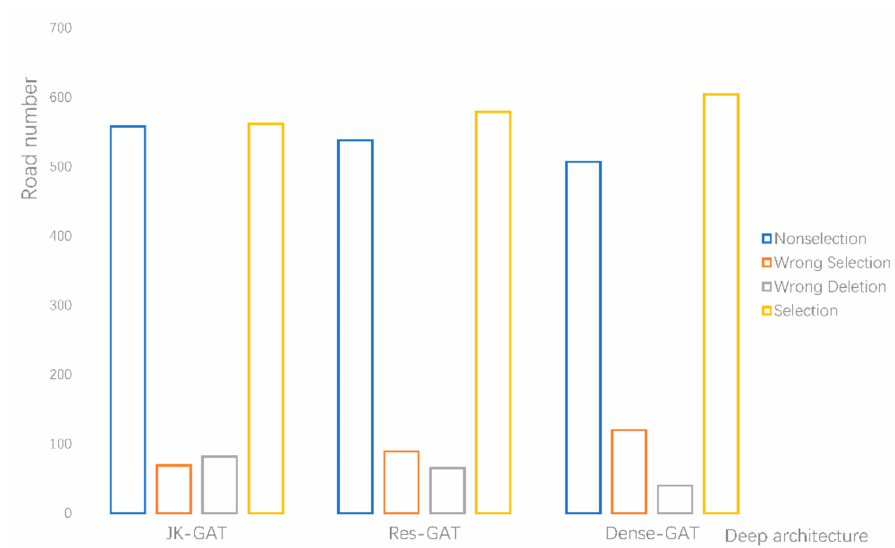
Figure 10. Distribution histogram of the predicted results of the GCN